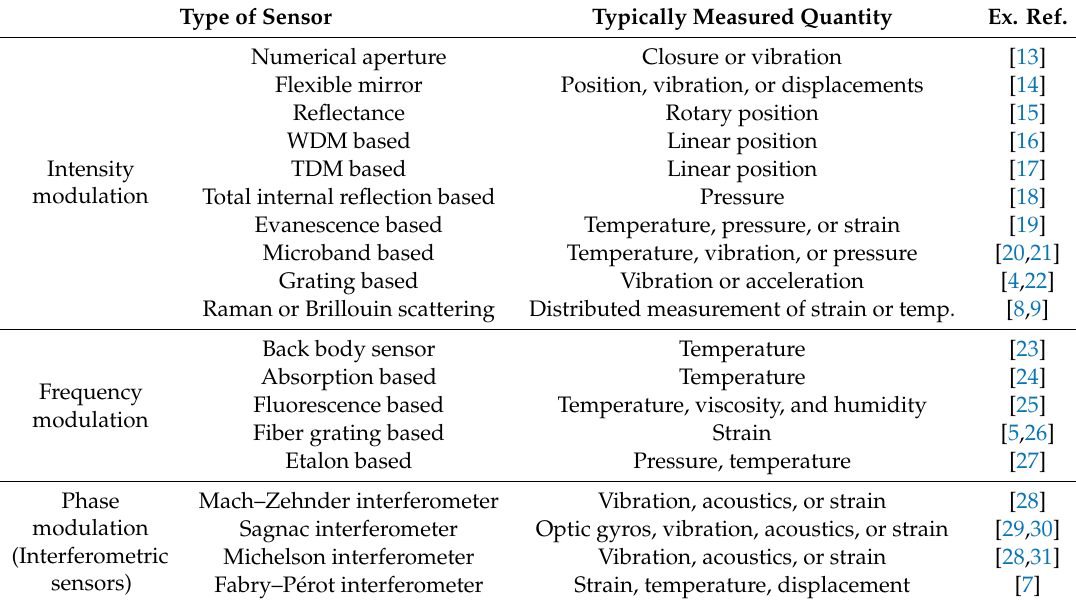
Table 2. Examples of optical sensors and their typical utilization (WDM: Wavelength-Division Multiplexing; TDM: Time-Division Multiplexing). Type of Sensor Typically Measured Quantity Ex.